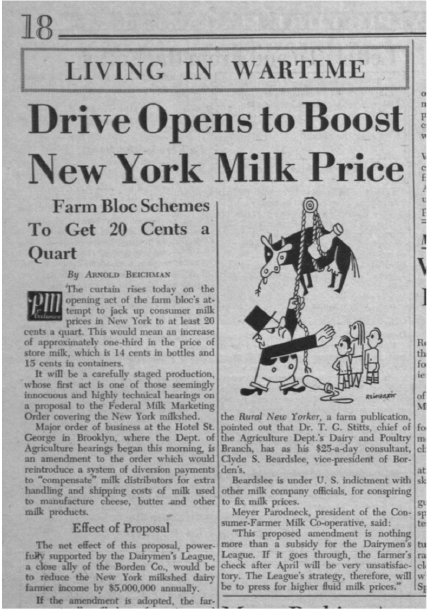
Figure 2. Arnold Beichman and Ad Reinhardt, “Drive Opens to Boost New York’s Milk Price”, PM , 16 March 1942. Image created by the author.